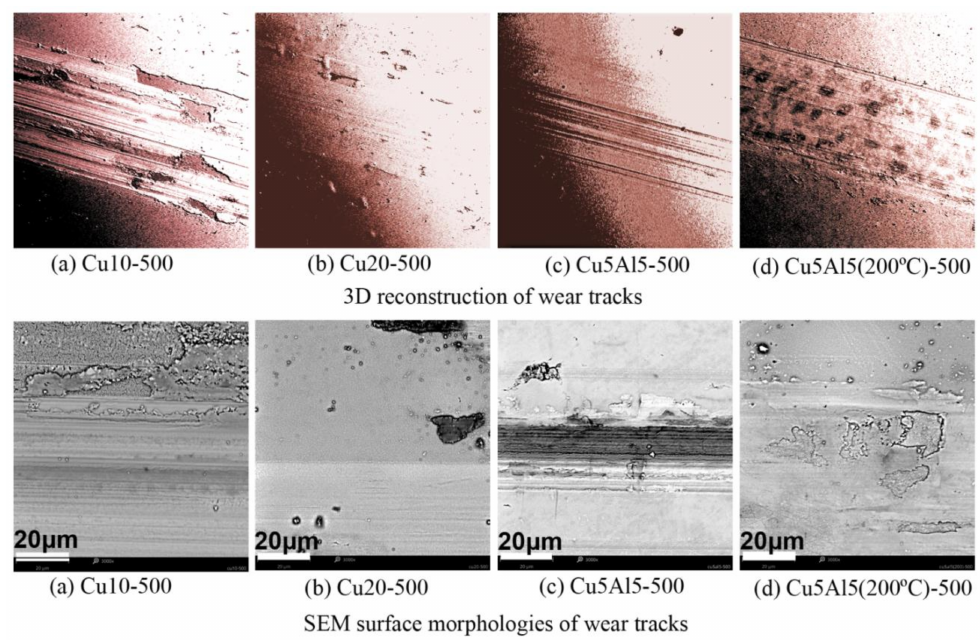
Figure 9. 3D reconstructions and SEM surface morphologies of wear tracks in coatings annealed at 500 ◦ C.